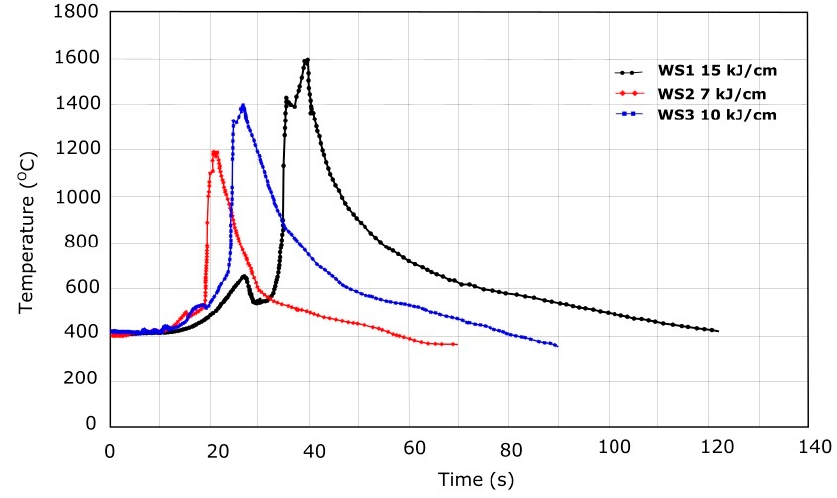
Figure 3. Thermal profile of the three weld samples.